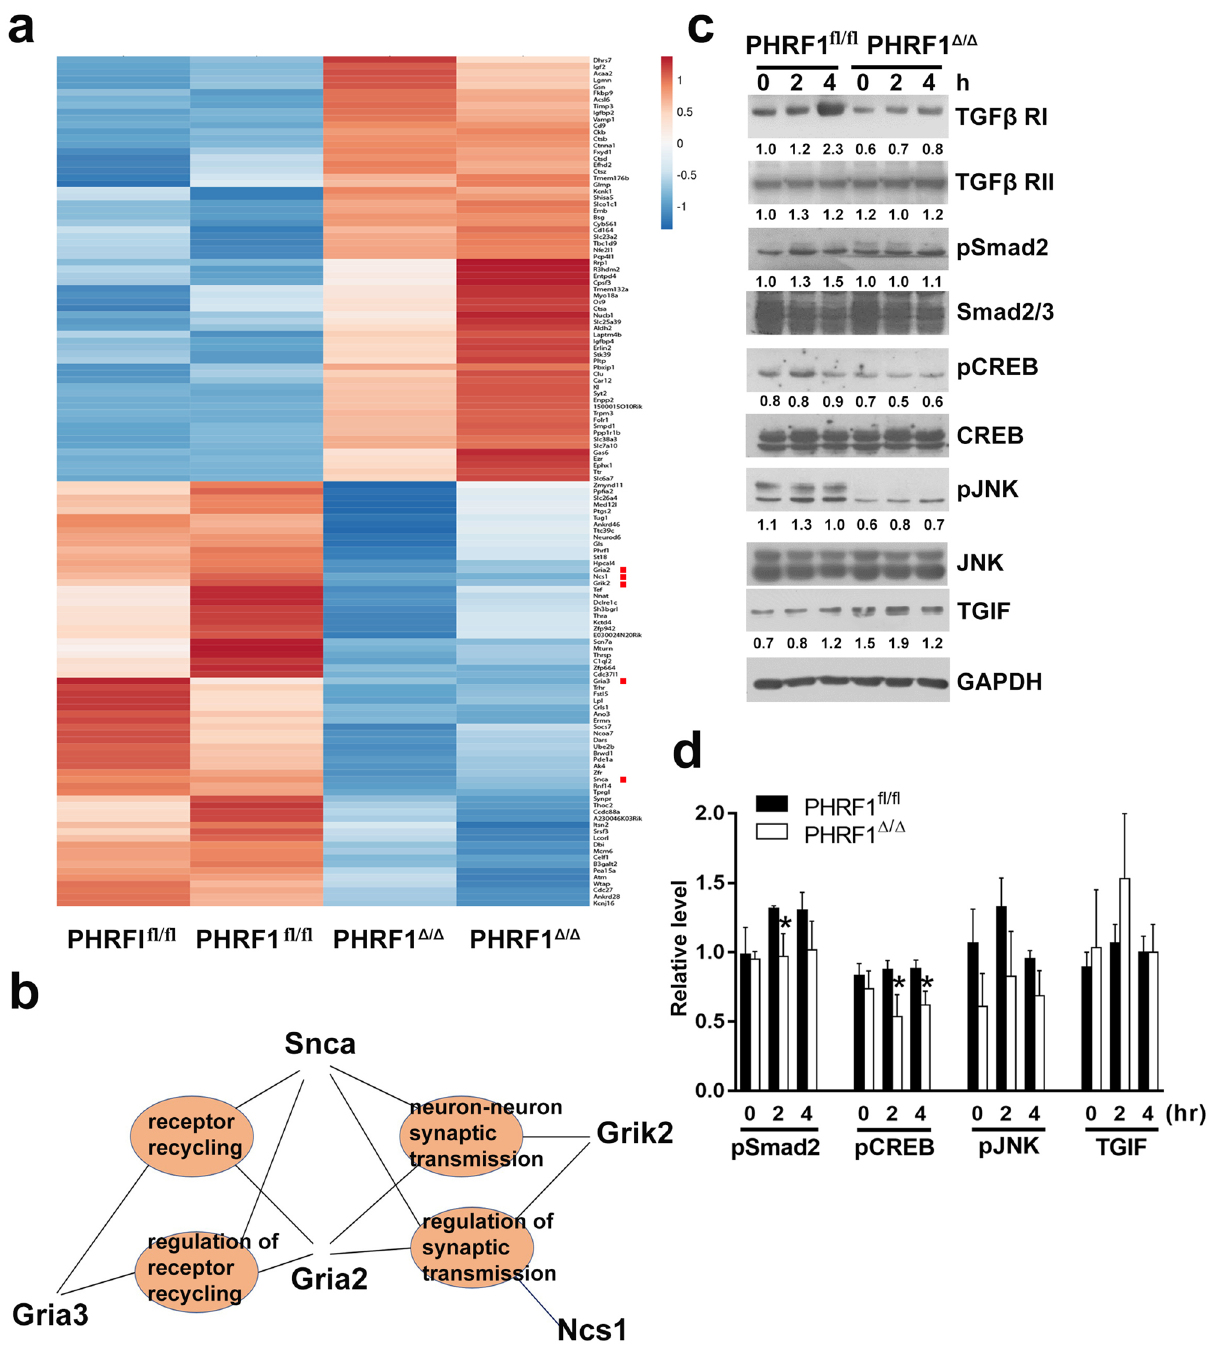
Figure 6. The altered expression of hippocampal genes involved in JNK and CREB signaling in PHRF1 Δ/Δ mice. ( a ) The Heatmap was generated using ClustVis by comparing top 65 up- and down-regulated genes in the hippocampi of 3-month-old PHRF1 fl/fl and PHRF1 Δ/Δ mice (n = 2 mice per group). Down-regulated genes are shown in blue shades and up-regulated genes are shown in red shades. ( b ) Identification of biological processes by Gene Ontology software based on the differentially down-expressed genes in PHRF1 Δ/Δ mice compared with PHRF1 fl/fl mice. ( c ) Hippocampal cells from 3-month-old PHRF1 fl/fl and PHRF1 Δ/Δ mice ( n = 3) were independently incubated with TGF-β1 (10 ng/ml) at indicated times and cell lysates were immunoblotted with indicated antibodies. Representative band intensity of phosphoproteins was measured by ImageJ software and normalized with their corresponding internal controls. All Western blots were processed in identical conditions and cropped from Supplementary Fig. S4b. ( d ) Relative phosphorylation levels of pSmad2, pCREB, and pJNK and the amount of TGIF were measured and quantified with their internal controls. Data are mean ± SEM. Student t-test, * p < 0.05. n =